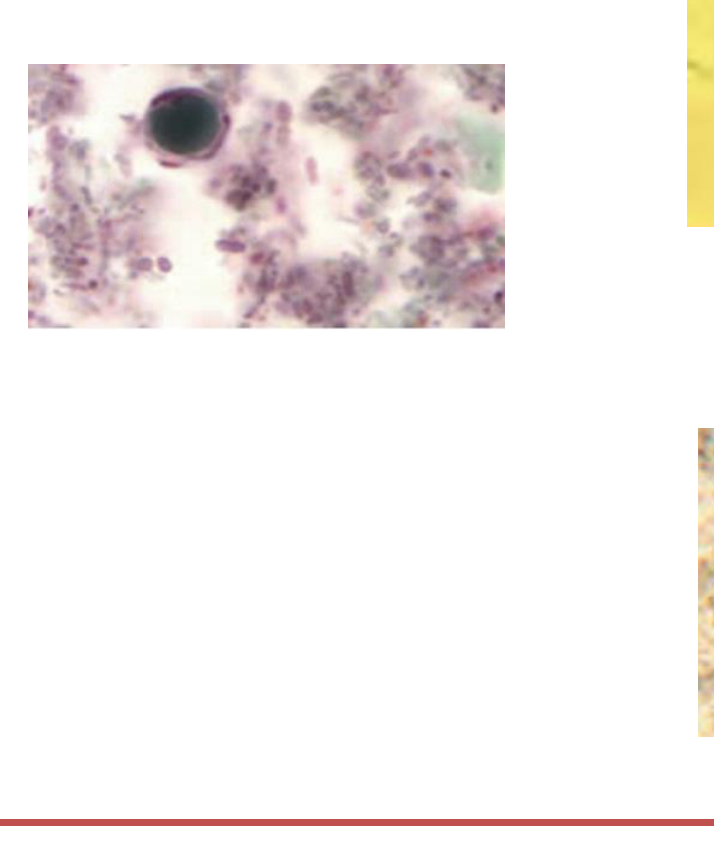
Fig.2: Comparison between efficacy of different staining methods for diagnosis of Blastocystis spp. in leukemic